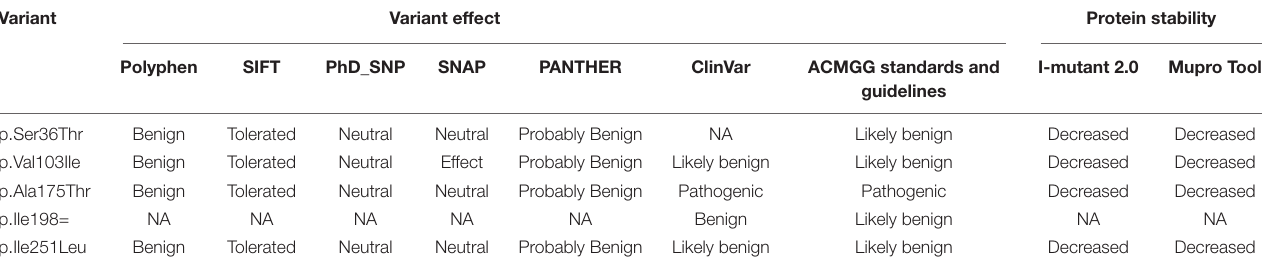
TABLE 3 | Predicted significance of the variants identified in the MC4R